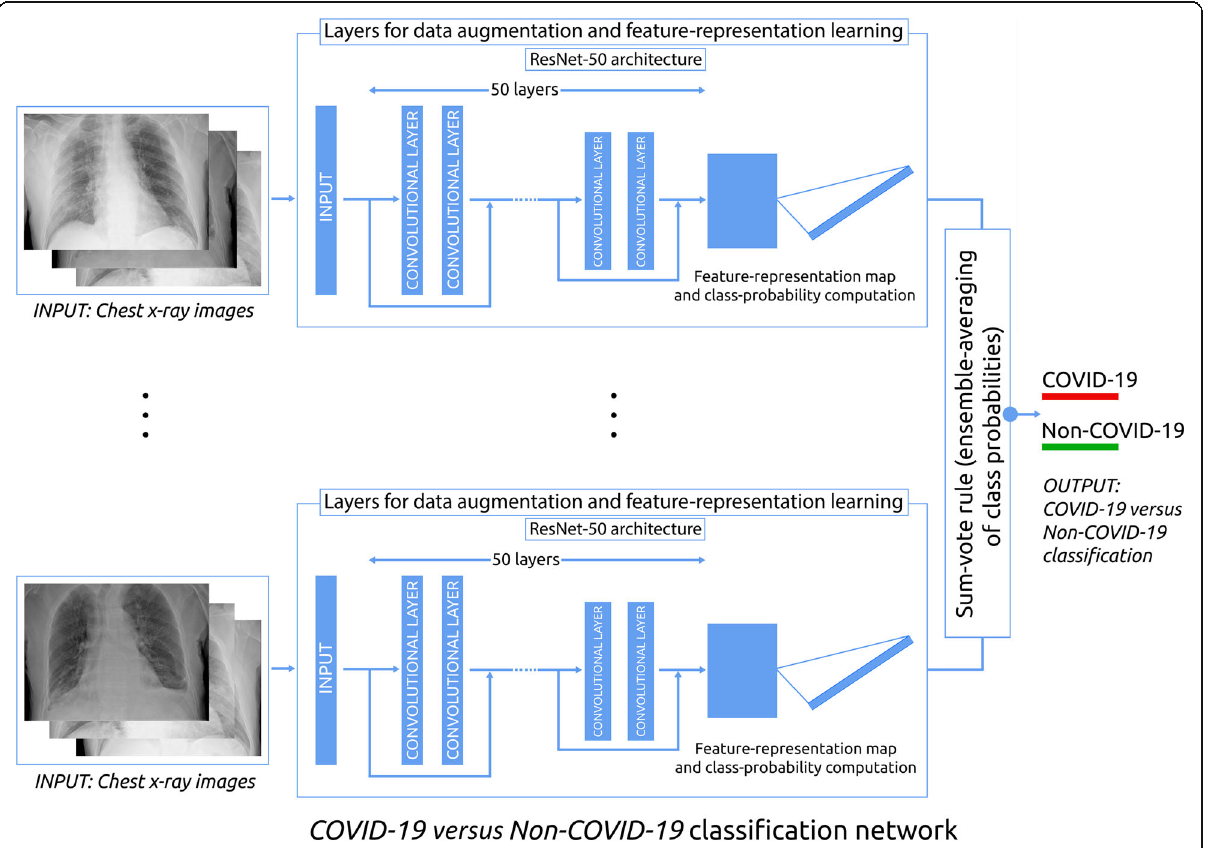
Fig. 2 Schematic drawing of the artificial intelligence network architecture for the classification of COVID-19 versus non-COVID-19 patients through chest-x-ray imaging COVID-19 Coronaviris disease